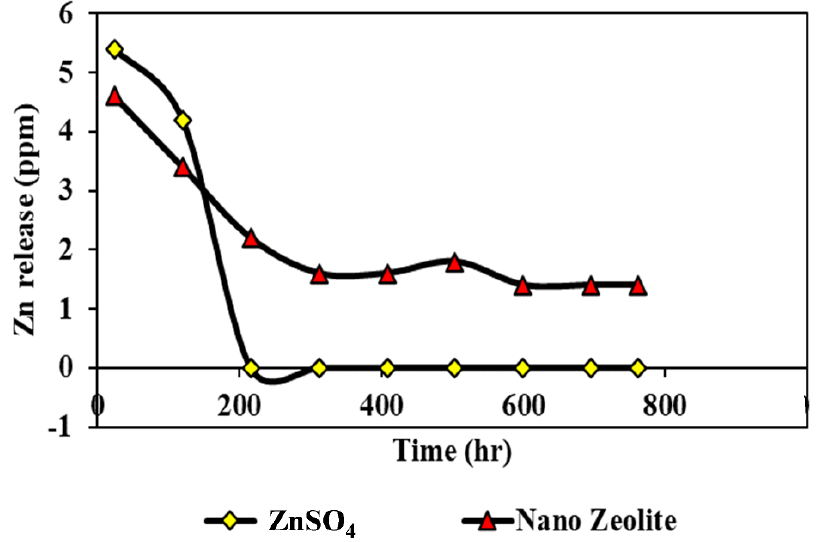
Figure 8. Zn Release Pattern with Time Duration as Influenced by Nano Zeolite Application. Modified from Yuvaraj and Subramaniannano [119].